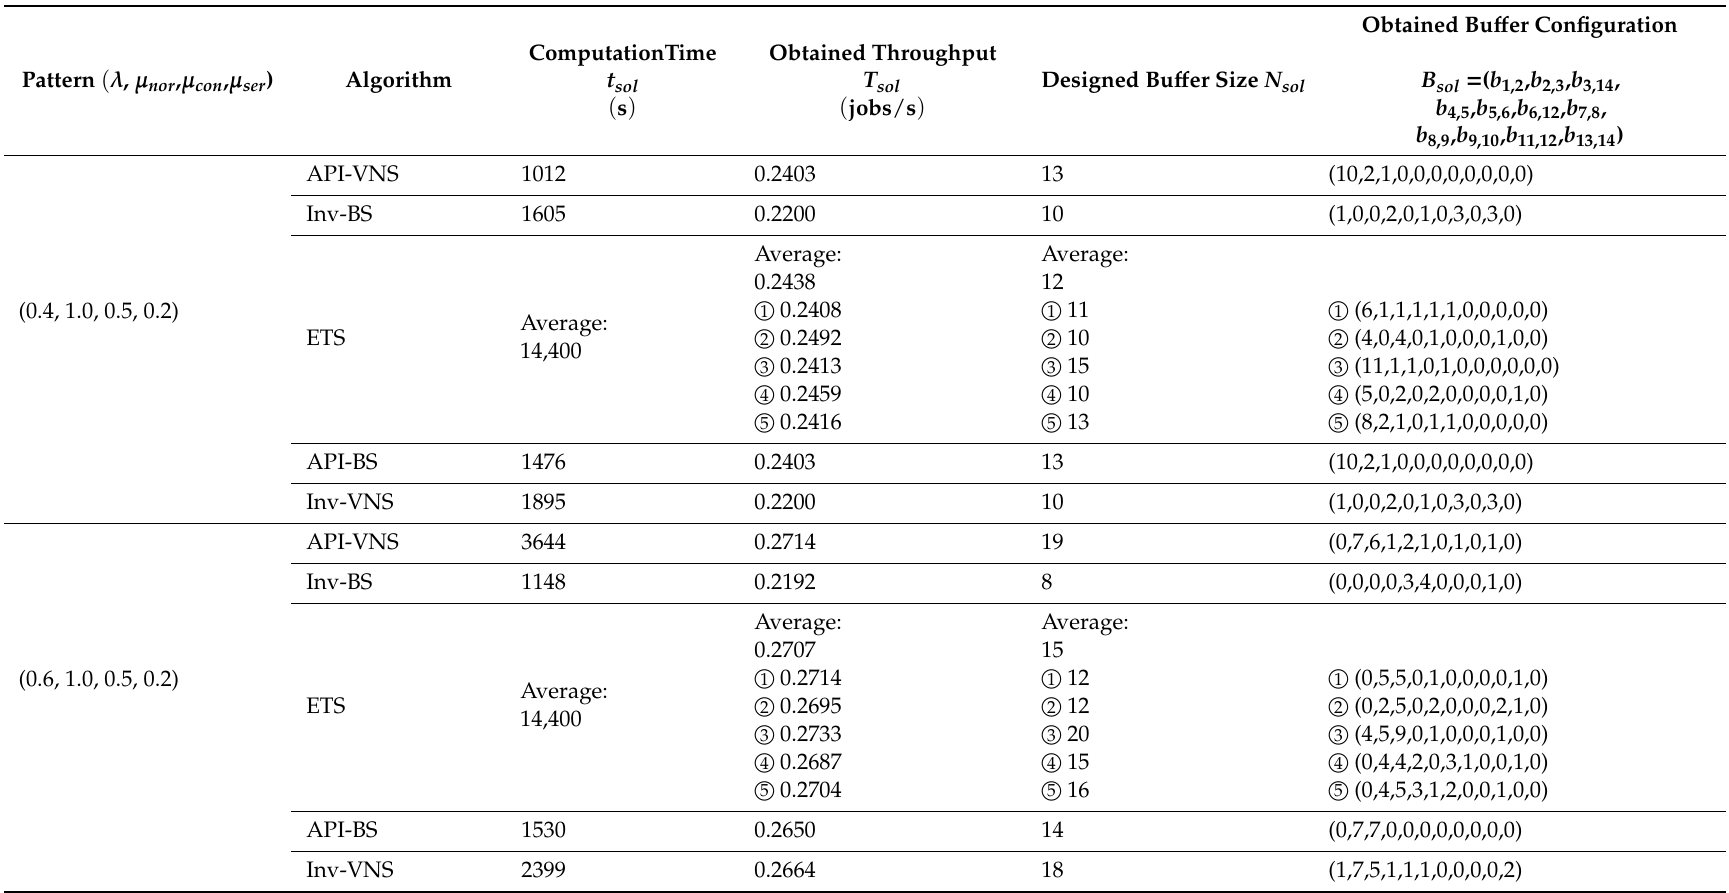
Table 3. Results of the five methods in experiment